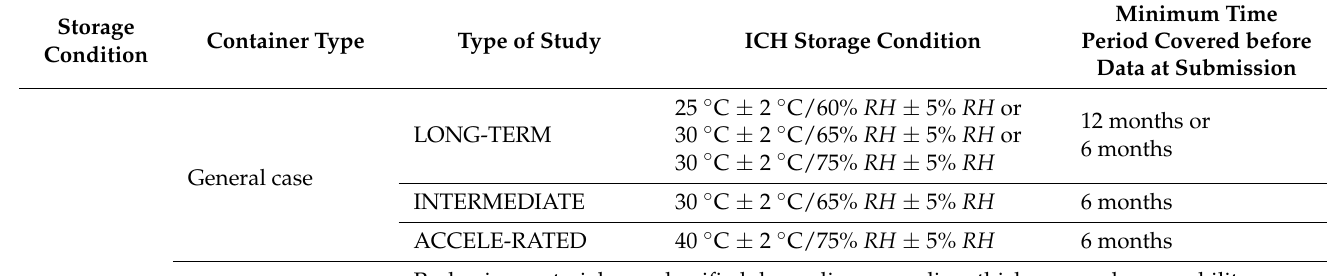
Table 3. Types of stability studies for FPPs. Modified from: [6,12]. Key: RT, Room